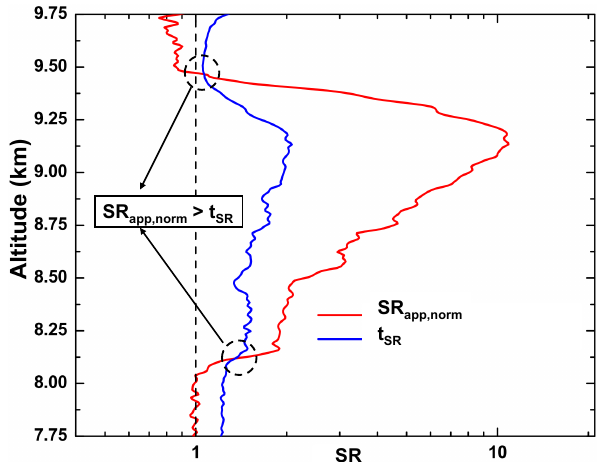
Fig. 3. Criterion to determine both the base and top heights from the apparent scattering ratio profile (red line) through threshold values (blue